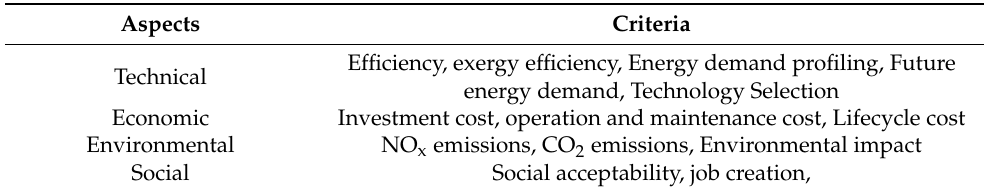
Table 2. List of evaluation criteria used in multicriteria decision-making studies conducted on energy